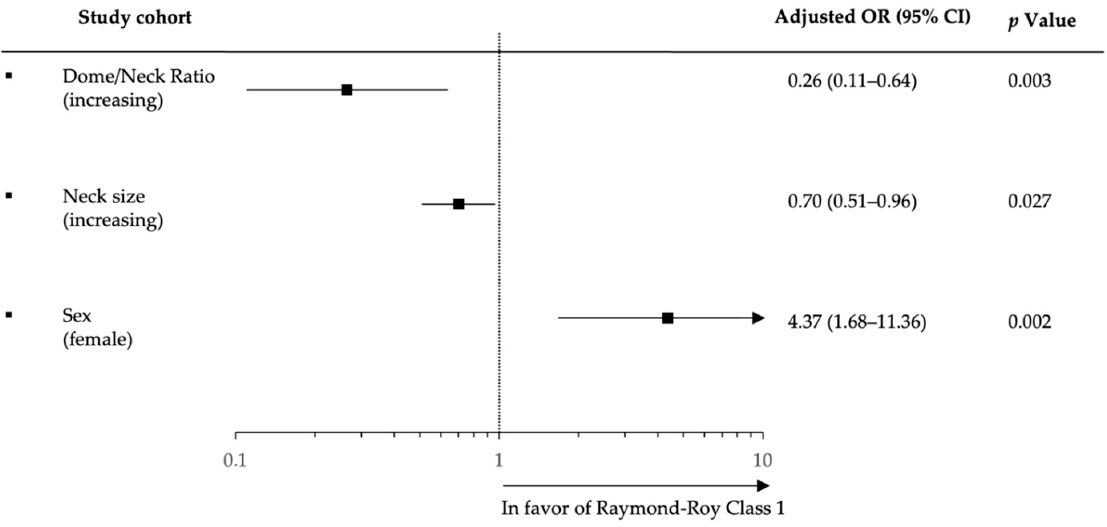
Figure 2. Forest plot based on stepwise multivariable logistic regression analysis for factors associated with complete aneurysm obliteration (Raymond–Roy occlusion class I) at last available follow-up assessed on digital subtraction angiography (DSA).